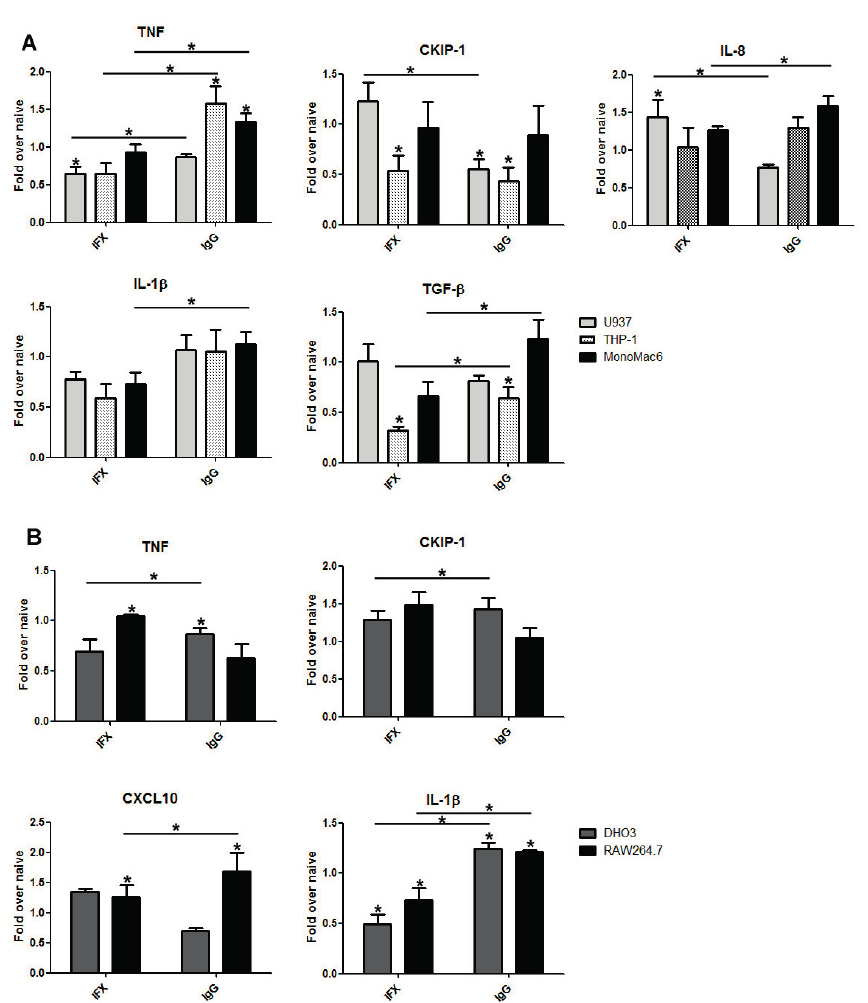
Figure 2. The effect of IFX is not dependent on the presence of the constant region (Fc) of IgG. Although IFX is a chimeric antibody that contains the Fc fragment of human IgG1, and myeloid cells carry Fc receptors, distinct relative gene expression patterns were demonstrated after IFX or IgG challenge in all investigated cell lines. To verify that the effect of reverse signaling is different from that of FcR signaling, the relative gene expression pattern of inflammation-related effector molecules were investigated in human ( A ) and mouse ( B ) monocytic cell lines 24 h after IFX or IgG stimulation. All of the investigated molecules show distinct relative gene expression pattern after IFX stimulation as compared with IgG treatment. Data show average ± SEM from at least three independent experiments. * Significantly different from controls (One-Way ANOVA following Neuman–Keuls post hoc